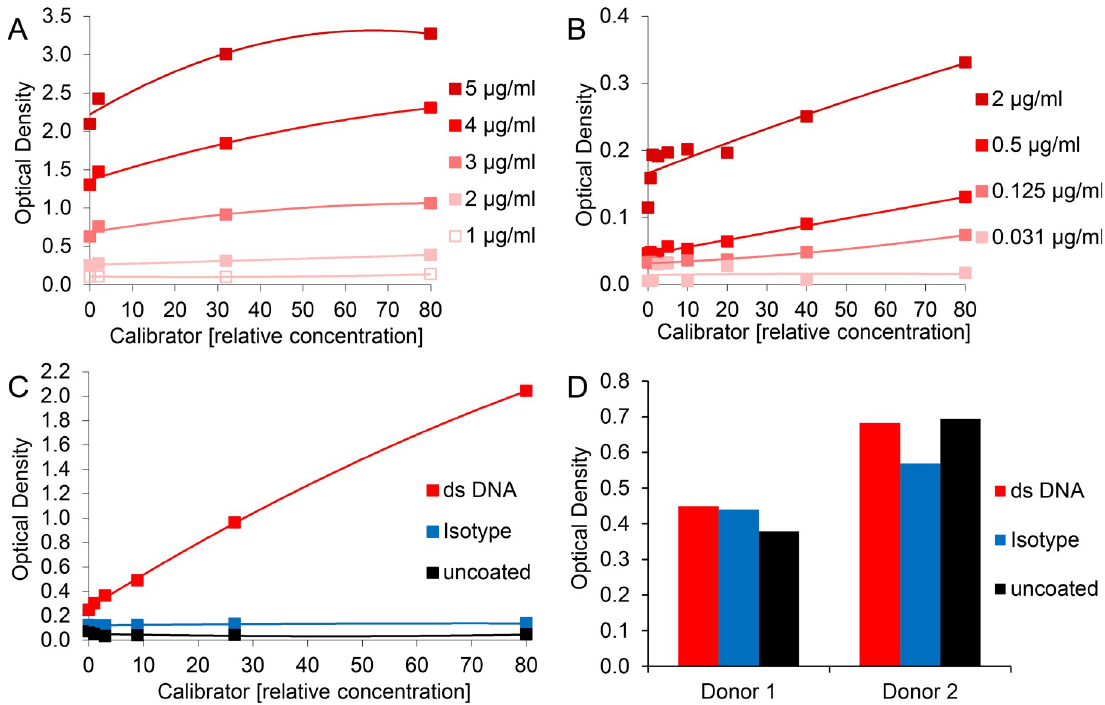
Fig 2. Exchange of assay antibodies does not eliminate unspecific reactions of plasma components. For assessment of A)—C) serially diluted calibrator and D) 1:2 diluted plasma, the following modifications of the initial MPO-DNA complex ELISA protocol were applied: Microwells were coated with A) 1 - 5 μ g/ml rabbit anti-human MPO polyclonal antibody (no. 07-496-I, EMD Millipore), B) 4 μ g/ml mouse anti-ds DNA monoclonal antibody (no. ab27156, Abcam) or C) and D) 1 μ g/ml mouse anti-ds DNA monoclonal antibody (no. ab27156, Abcam), 1 μ g/ml mouse IgG2a kappa monoclonal isotype control (no. 010-001-332, Rockland Immunochemicals) or were left uncoated. For MPO-DNA complex detection A) peroxidase-conjugated mouse anti-DNA monoclonal antibody (clone MCA-33, as described for the initial ELISA protocol), B) 0.031 – 2 μ g/ml HRP-labeled mouse anti-human MPO monoclonal antibody (no. NBP2- 41406H, Bio-Techne) or C) and D) 0.5 μ g/ml biotinylated mouse anti-human MPO monoclonal antibody (no. HM2164BT, HyCult Biotech) followed by 0.5 μ g/ml streptavidin-HRP were